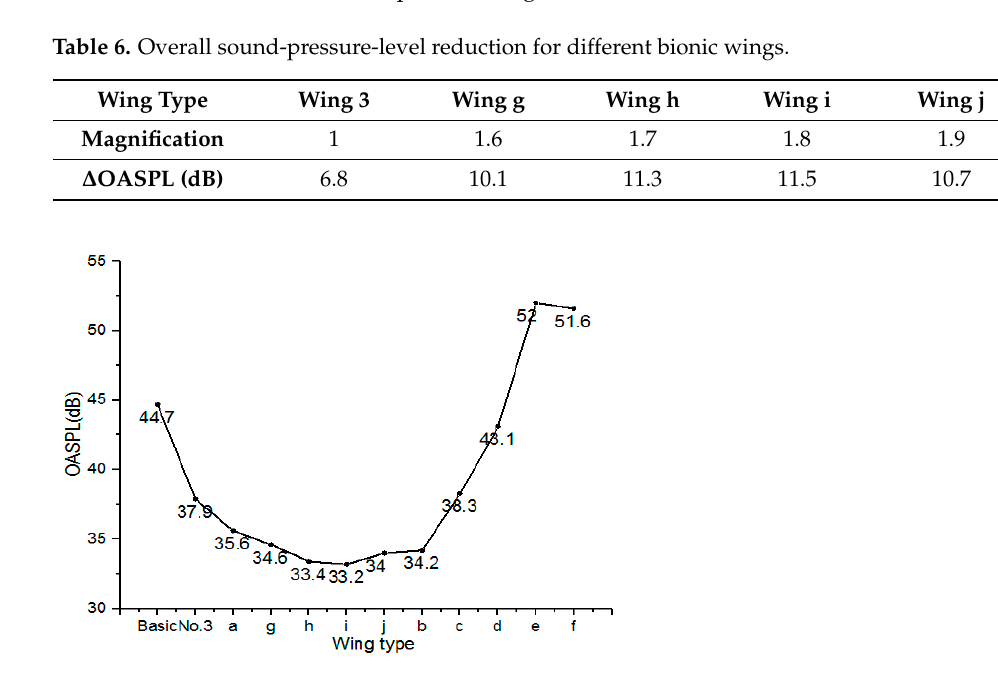
Figure 4. Overall sound pressure levels of different bionic wings.